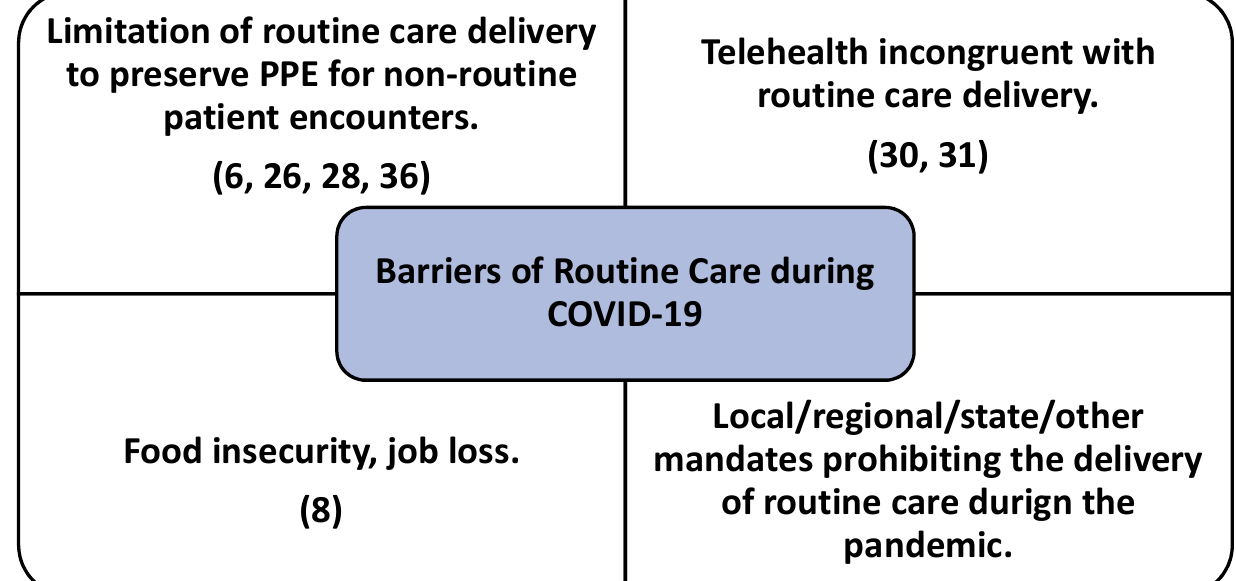
Figure 3. Underlying variables (constructs) identified as barriers for the delivery of routine care during the pandemic.